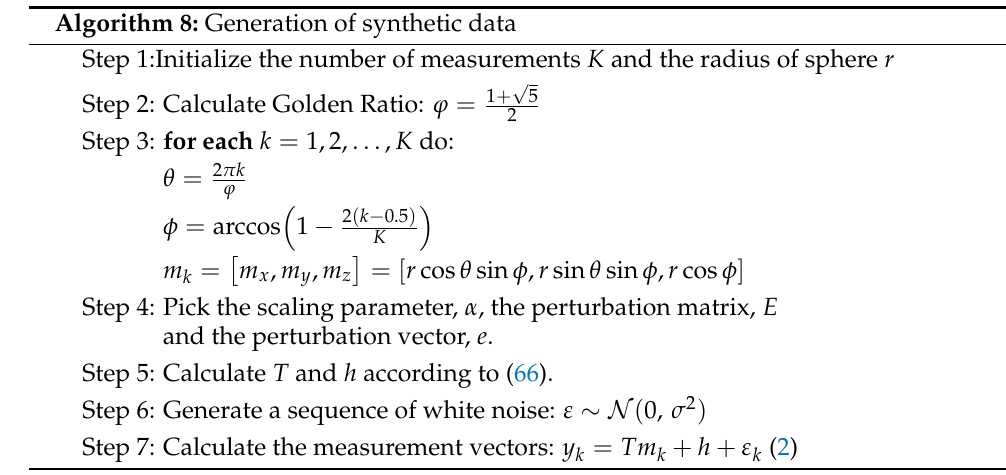
Algorithm 8: Generation of synthetic data